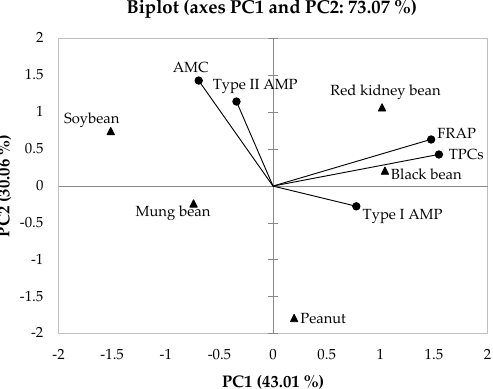
Figure 6. The biplot from principal component analysis (PCA) derived from mean values of all vari- ables (% anti-mutagenicity, FRAP activities and TPCs) of five bean milks. AMC: % anti-mutagenicity from co-administration study; Type I AMP: % anti-mutagenicity from type I pre-feeding study; Type II AMP: % anti-mutagenicity from type II pre-feeding study; FRAP: ferric reducing antioxidant power; TPCs: total phenolic contents.